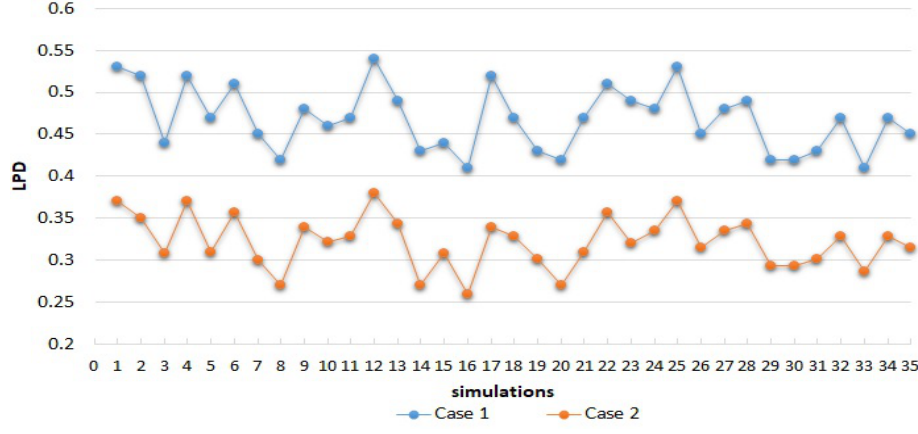
Figure 10. LPD index in Cases 1 and 2.